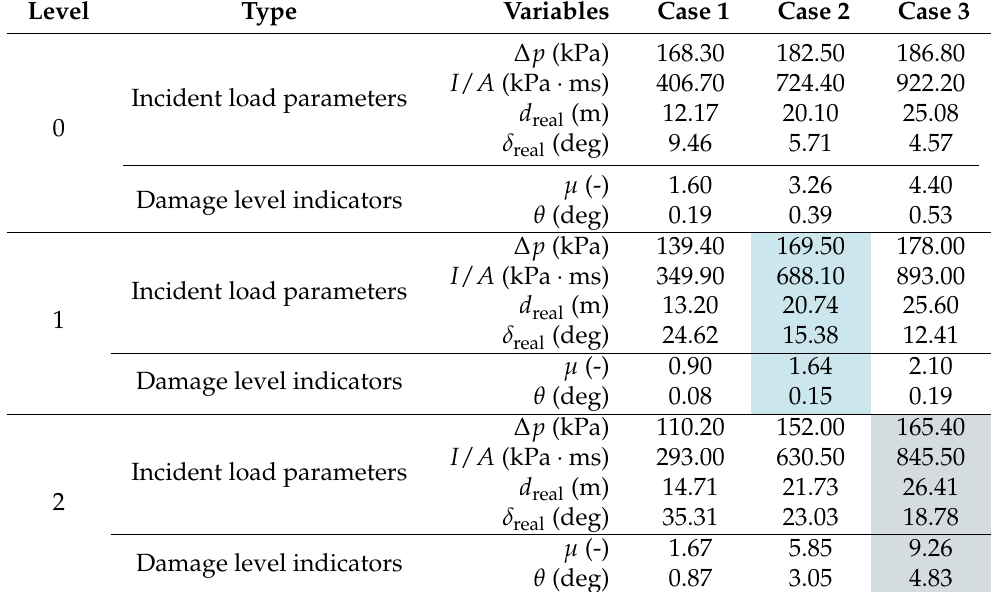
Table 5. Incident load parameters and component damage indicators per floor. According to the PDC-TR-06-08 [15], the response limits for hot rolled structural steel can be defined in terms of the ductility ratio, µ , and support rotation angle, θ , as follows: B1—superficial { µ , θ } = { 1, −} ; B2—moderate { µ , θ } = { 3,3 ◦ } ; B3—heavy { µ , θ } = { 12,10 ◦ } ; B4—hazardous { µ , θ } = { 25,20 ◦ } . The reference case and worst-case scenario are indicated in blue and gray,